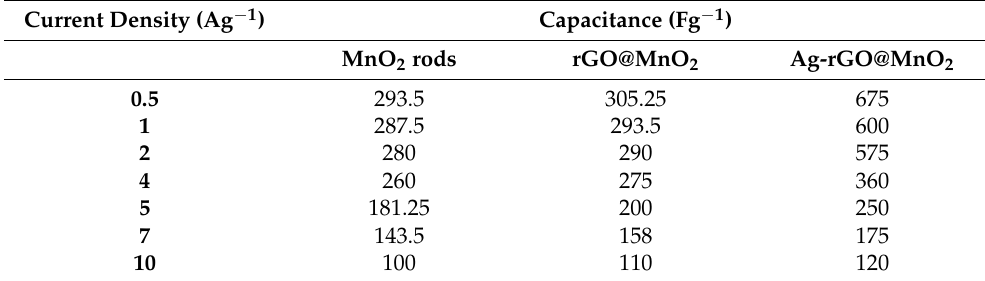
Table 2. Capacitive values of MnO 2 rods, rGO@MnO 2 , and Ag-rGO@MnO 2 at different current densities.